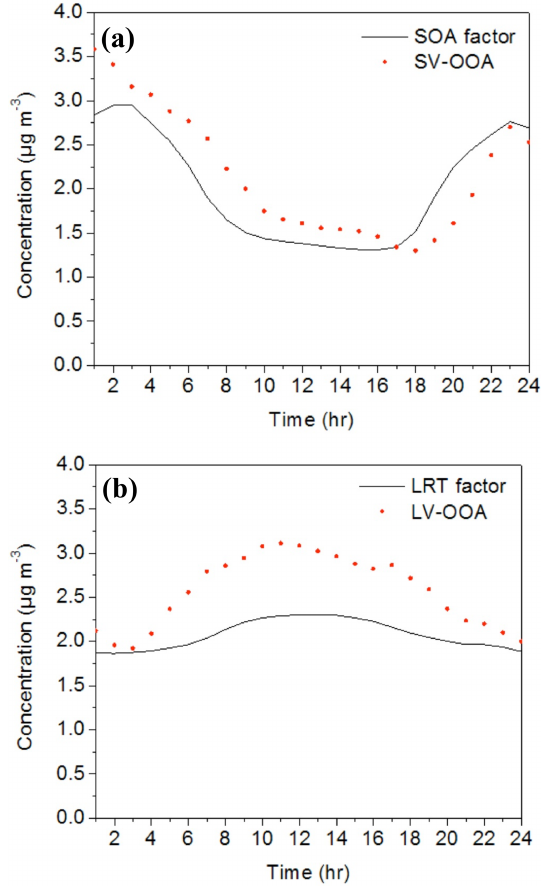
Figure 3. Comparison of average diurnal profiles of factors of PMF analysis of PMCAMx-SR results and PMF analysis of AMS mea- surements in Melpitz: (a) SOA factor and SV-OOA and (b) LRT factor and LV-OOA.